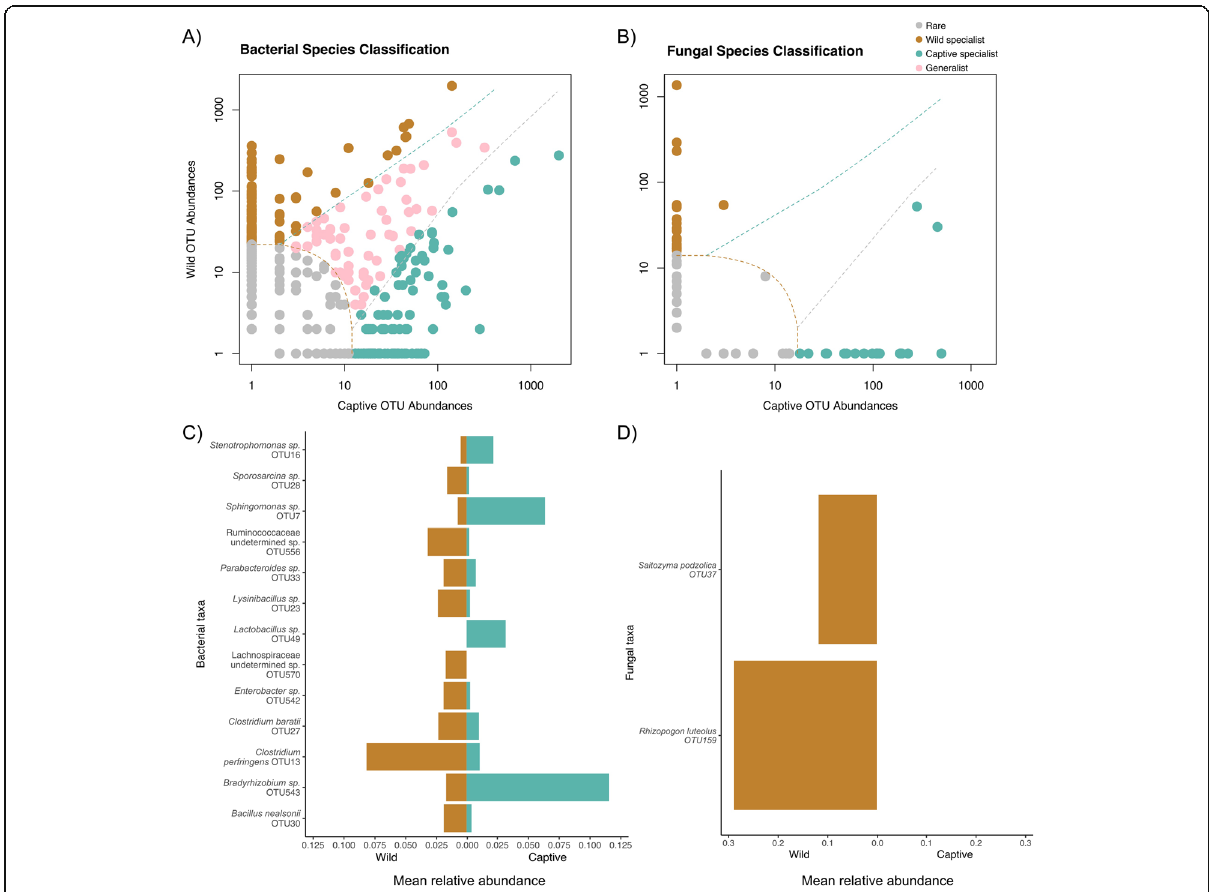
Fig. 3 Distinct microbial taxa are classed by their representation in captive and wild kiwi . A multinomial species classification method (clamtest) categorized bacterial and fungal OTUs into one of four classes: rare, generalist, wild specialist, and captive specialist. A For bacterial OTUs, 9.9 % were classed as generalist, 53 % as rare, 19.7 % as wild specialist, and 17.4 % as captive specialist. B For fungal OTUs, 0 % were classed as generalist, 46.7 % as rare, 26.7 % as wild specialist, and 26.7 % as captive specialist. Simper analysis detected several OTUs that explained 70 % difference between captive and wild kiwi. OTUs that were classed as either wild specialist or captive specialist in the clamtest were also represented in the same condition with simper. C Nine bacterial OTUs were significantly represented in wild kiwi and four bacterial OTUs in captive kiwi (FDR adjusted p < 0.05). D Two fungal OTUs were significantly represented in wild kiwi (FDR adjusted p <